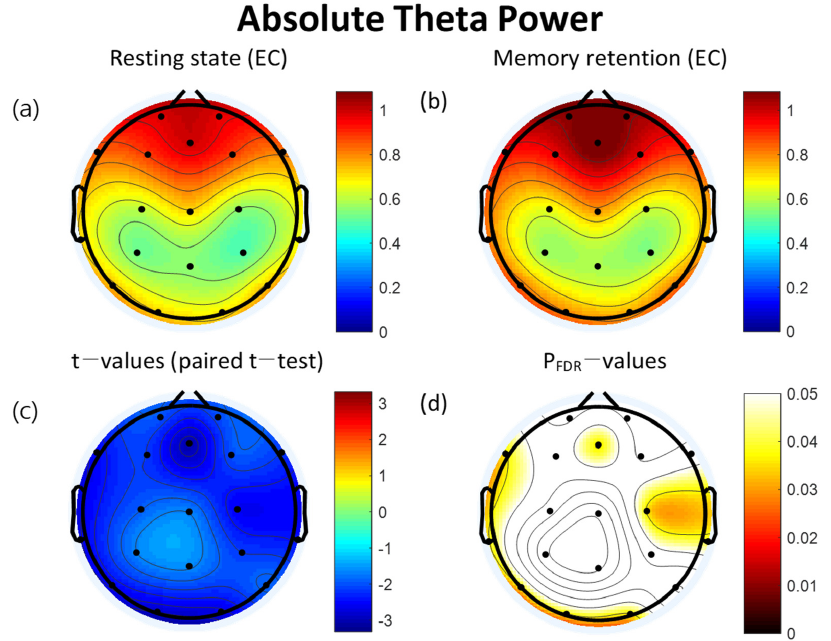
Figure 2. Topographies of absolute theta power during eyes-closed resting state and the retention interval of the visual working memory (VWM) task, t- map, and p FDR -map. ( a ) Absolute spectral power of theta band during the resting state ( b ) Absolute spectral power of theta band during the retention interval of VWM task ( c ) Topographical distribution of t- values (paired t- test) ( d ) Topographical distribution of the corresponding False Discovery Rate corrected p -values (paired t -test). EC: eyes closed, FDR: False Discovery Rate. For the absolute gamma power, the retention interval period of the VWM task had significantly increased at five of the electrodes: Fz (t = − 2.95, p = 0.044), O2 (t = − 2.70, p = 0.046), P3 (t = − 2.66, p = 0.046), C3 (t = − 2.60, p = 0.046), and Cz (t = − 3.20, p = 0.043). All significant differences were FDR corrected (Table 3). The topographical features of the paired t- test results are also presented in Figure 3. Table 3. Comparisons of absolute gamma power during the resting state and the retention interval of the VWM task in healthy volunteers.